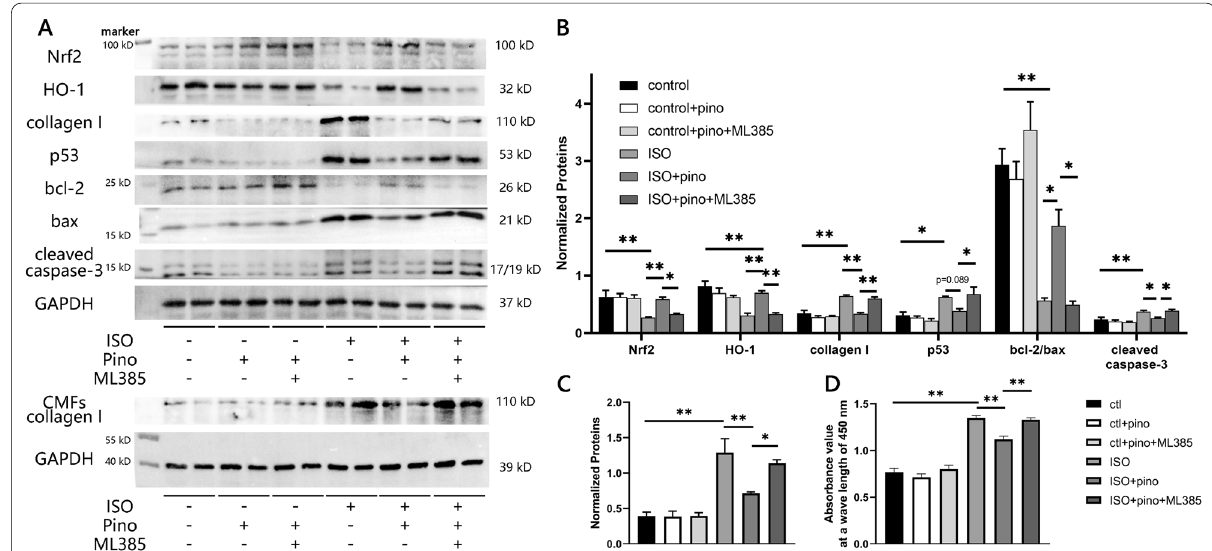
Fig. 6 5 μM ML385 abrogated the salutary effects exerted by pinocembrin on remodeling. A ML385 significantly inhibited Nrf2/HO-1 signaling pathway, subsequently contributing to the exacerbation of key remodeling factors including fibrosis and apoptosis; B the statistic analysis for western blot. N 4 for quantified analysis for every protein panel. C and D Quantification analysis of collagen I protein level and proliferation of = CMFs. *p < 0.05; **p < 0.01. Nrf2 nuclear factor erythroid 2-related factor 2, HO-1 heme oxygenase-1, CMFs cardiac